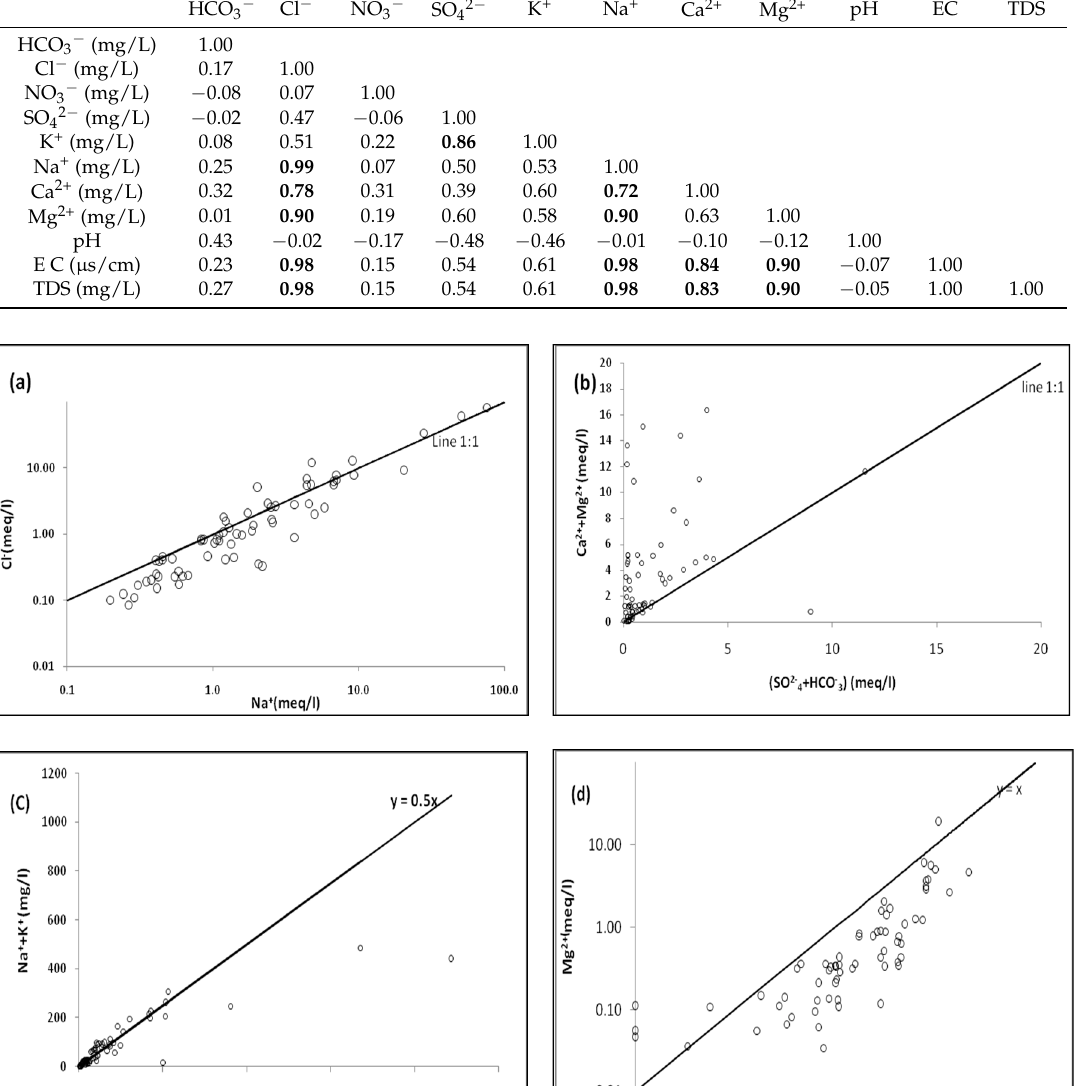
Table 3. Correlation between pairs of physiochemical parameters of groundwater quality. High correlation are shown in bold.